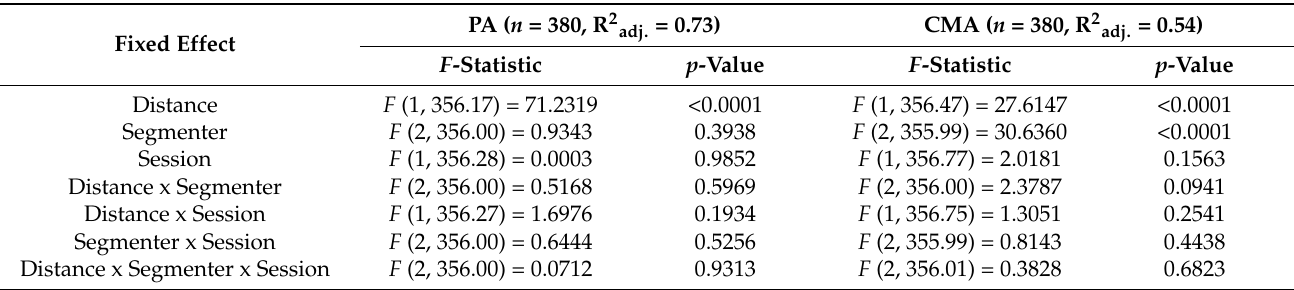
Table 3. Results of the linear mixed-effects models with the dependent variables perpendicular axis (PA) and ciliary muscle area